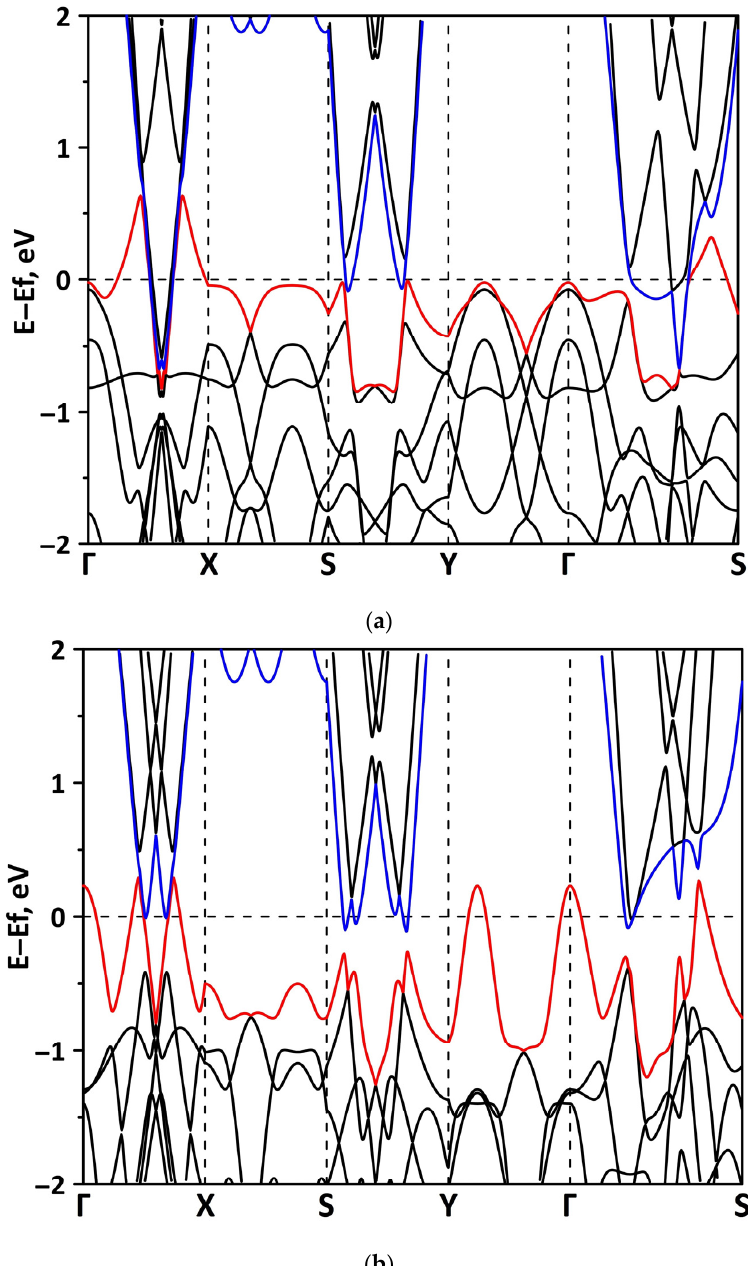
Figure 11. Fragments of the band diagrams near the Fermi level (shifted to 0 eV) of borophene/ZnO heterostructure under uniaxial compression by 1% ( a ) and 14% ( b ). The VBM is highlighted in red and the CBM is highlighted in blue.